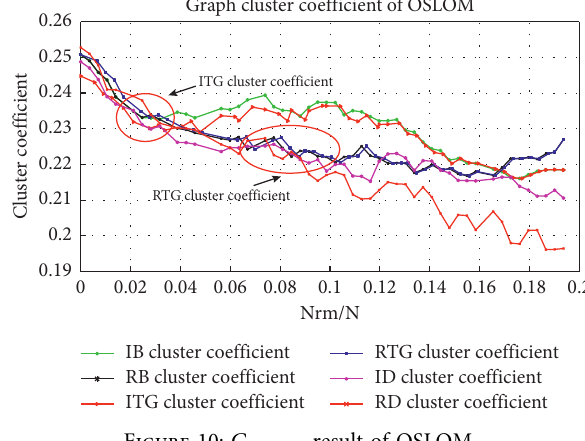
Figure 10: C G �( V,E ) result of OSLOM.